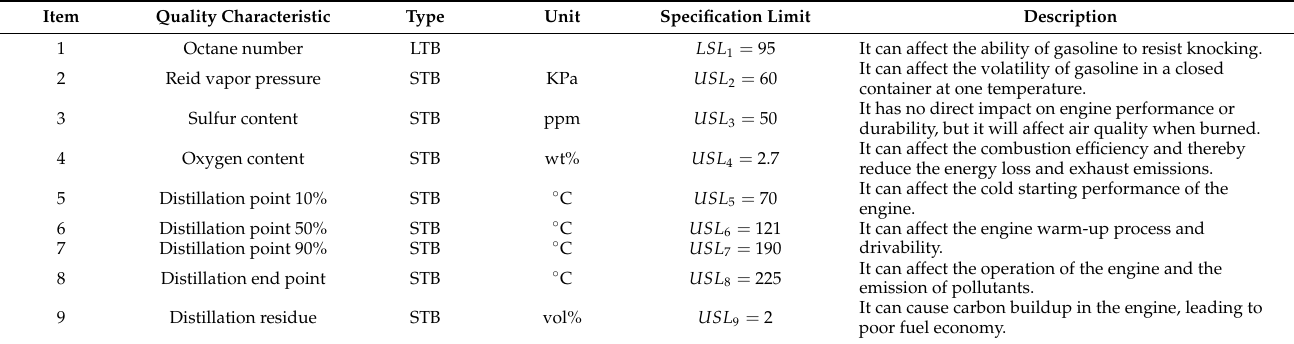
Table 1. Specifications of 95 unleaded